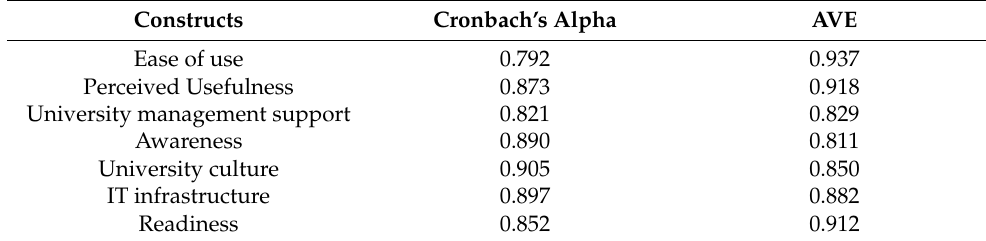
Table 2. Reliability and convergent validity analysis.